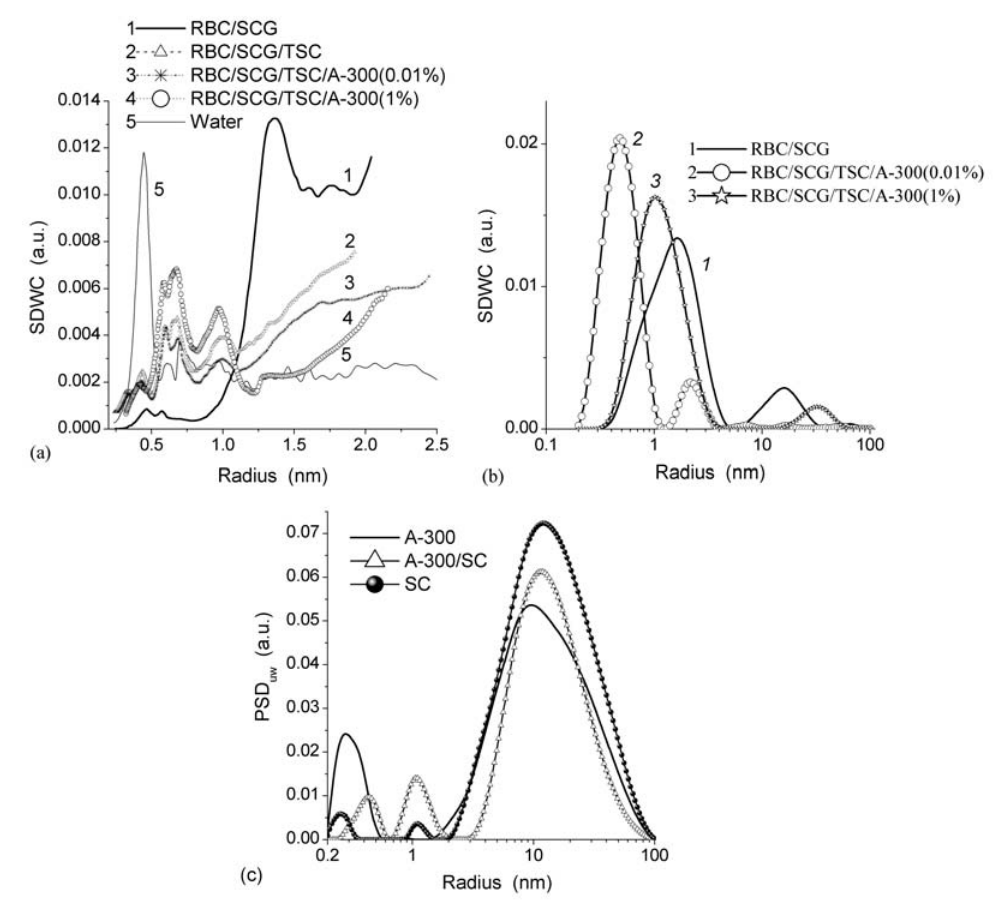
Fig. 8 Distribution functions of sizes of water clusters relaxing during TSDC measure- ments and calculated using (a) Eq. (3) for different systems with RBCs (in two buffers), RBC/A-300 (two concentrations of A-300) and pure water, and (b) Eq. (4); (c) distri- bution functions of sizes of unfrozen water structures in aqueous suspensions of A-300 (6 wt.%), shadow corpuscles (CS, 1.5 wt.%) and a mixture of A-300 (6 wt.%) and CS (1.5 wt.%) calculated on the basis of 1 H NMR spectra of unfrozen water at 200 < T < 273 K. Table 2 Activation energy (kJ/mol) of the dc relaxation System E a,dc Distilled water 125 NaCl (0.9